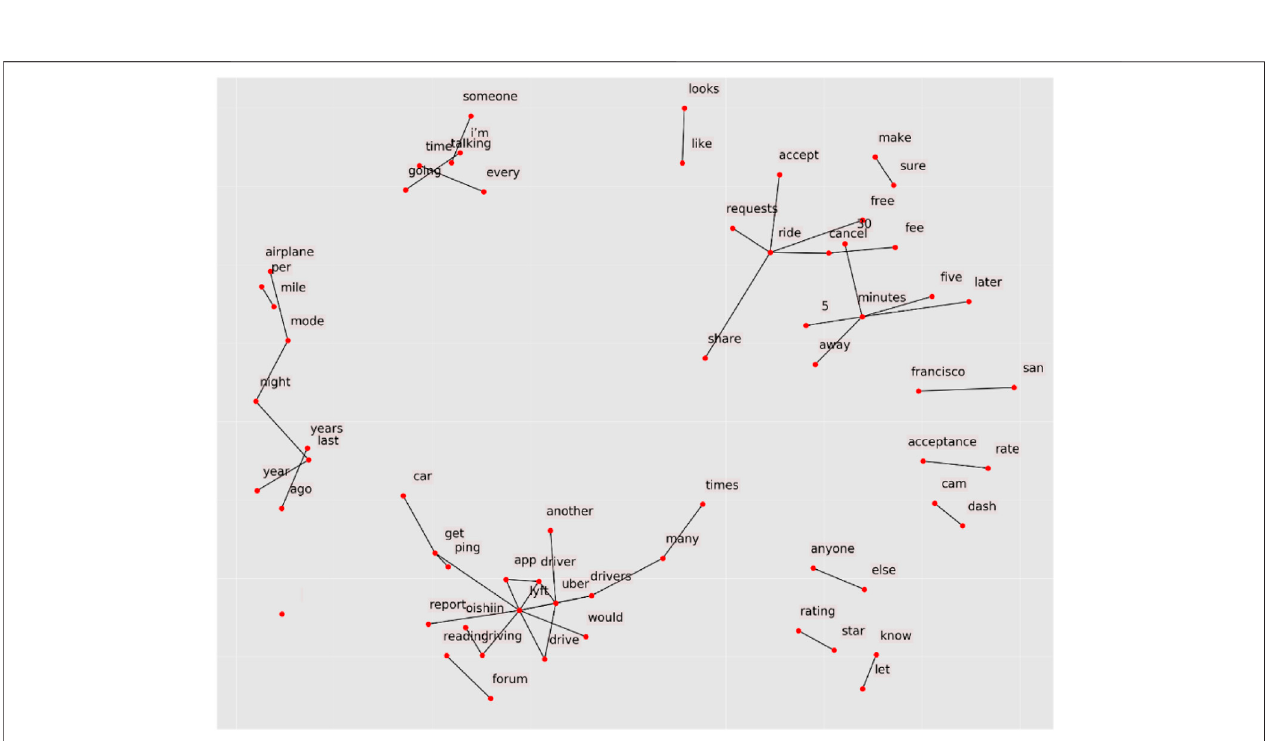
FIGURE 5 | Bigram of Lyft